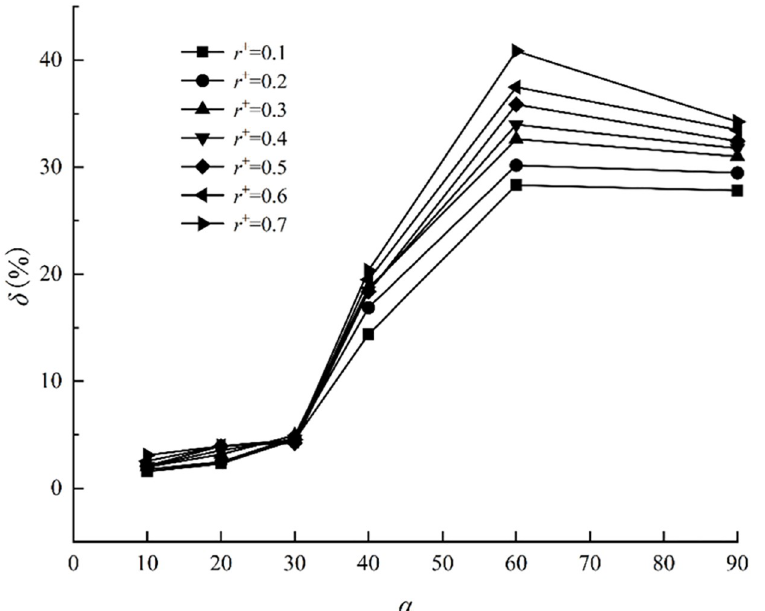
Fig 5. Average deviation distribution of different interval